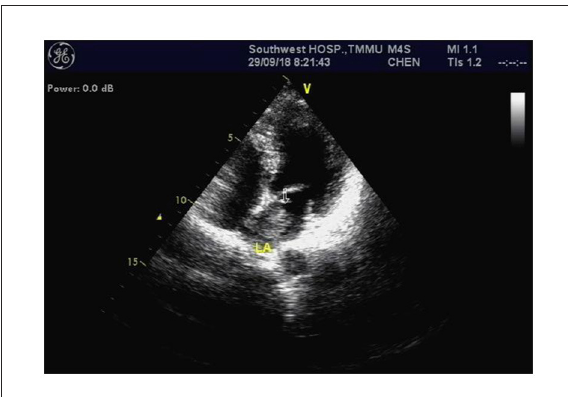
FIGURE3 Cardiac echocardiography revealed a left atrium myxoma measuring ∼ 27 × 13 millimeters (arrow).